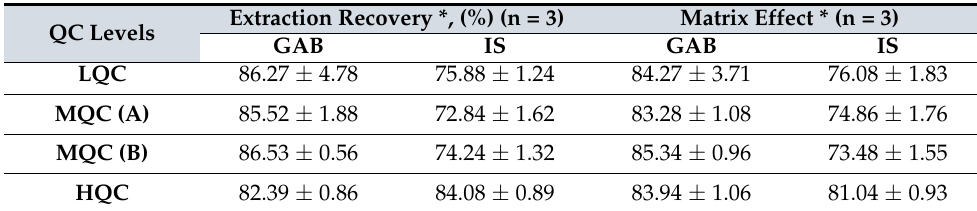
Table 4. Data for extraction recovery and matrix influence for the assessment of GAB by the new method, in human